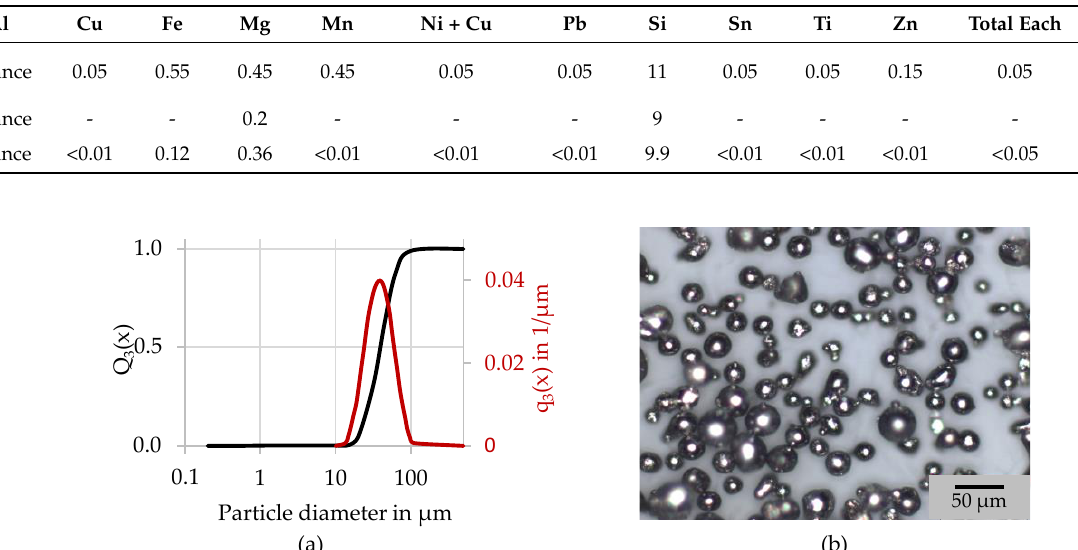
Table 1. Chemical composition of the used powder [16].